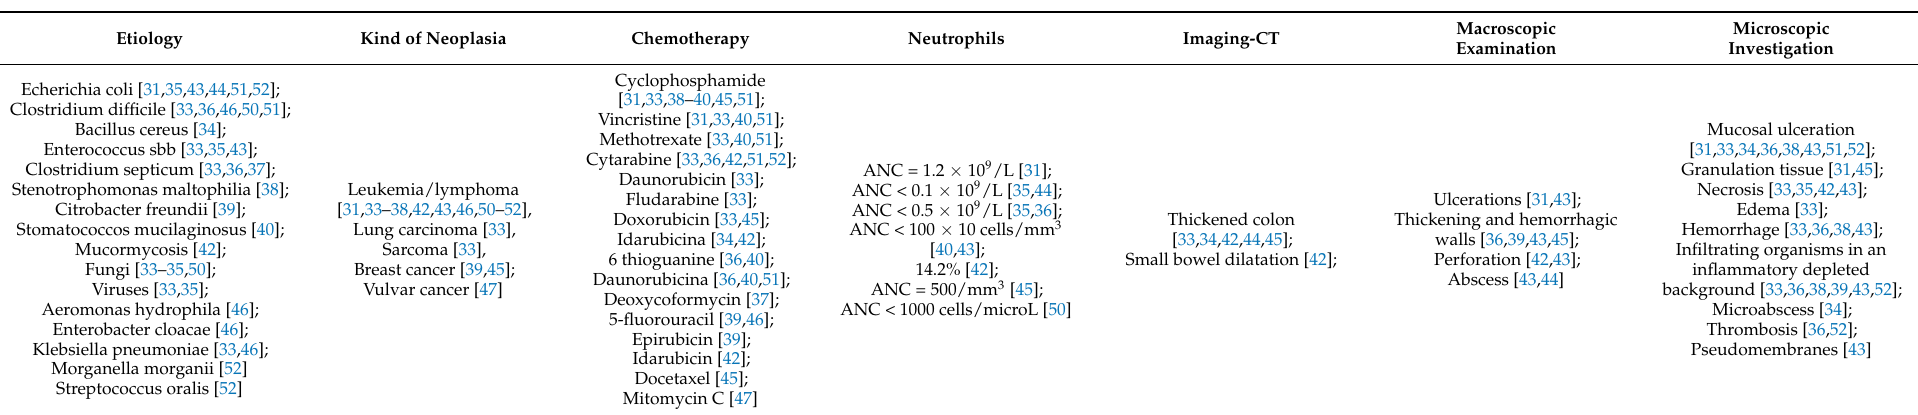
Table 1. Summary of the literature